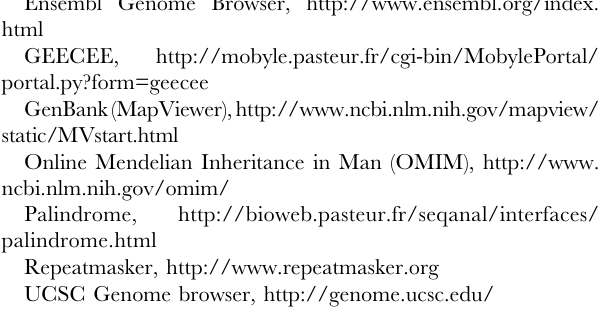
Figure S1 Alignment of PISRT1 homologues based on BLAST